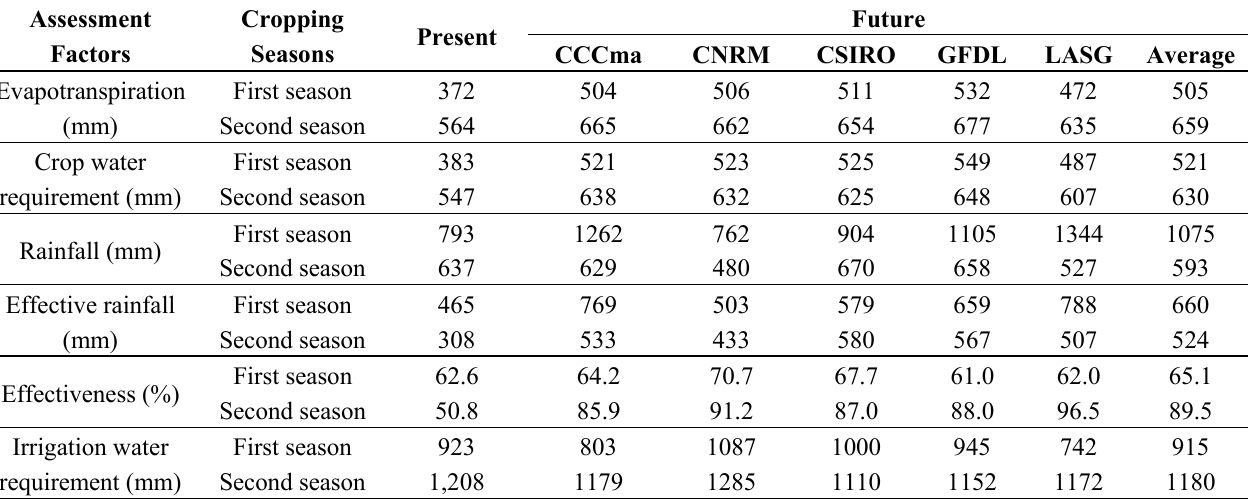
Table 3. The assessment of water consumption and supply for paddy field in the present and